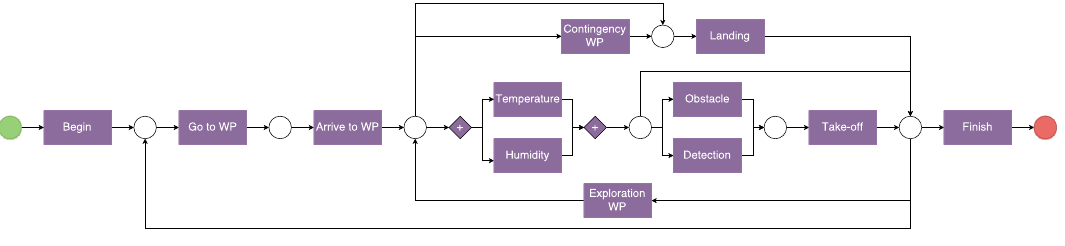
Figure 6. Mission